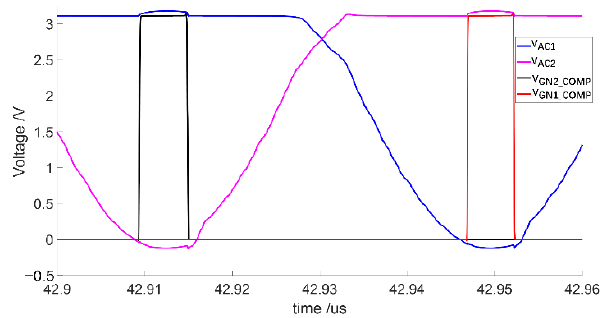
Figure 14. The main experimental transient waveform of the proposed rectifier.